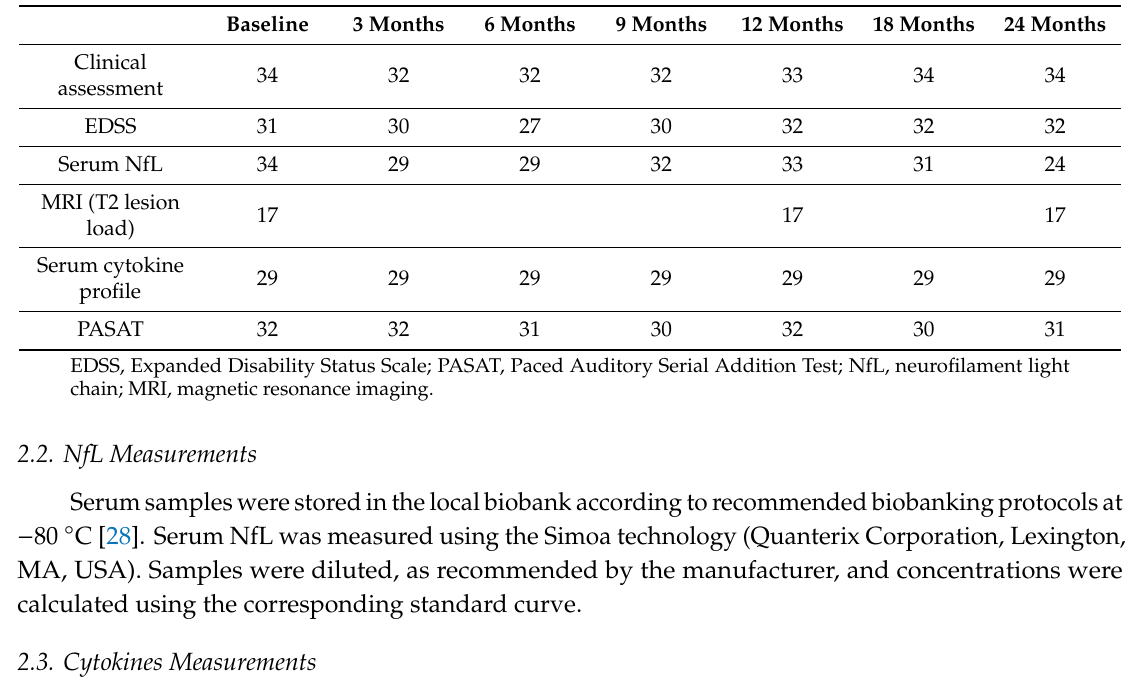
Table 2. Study schedule and number of available